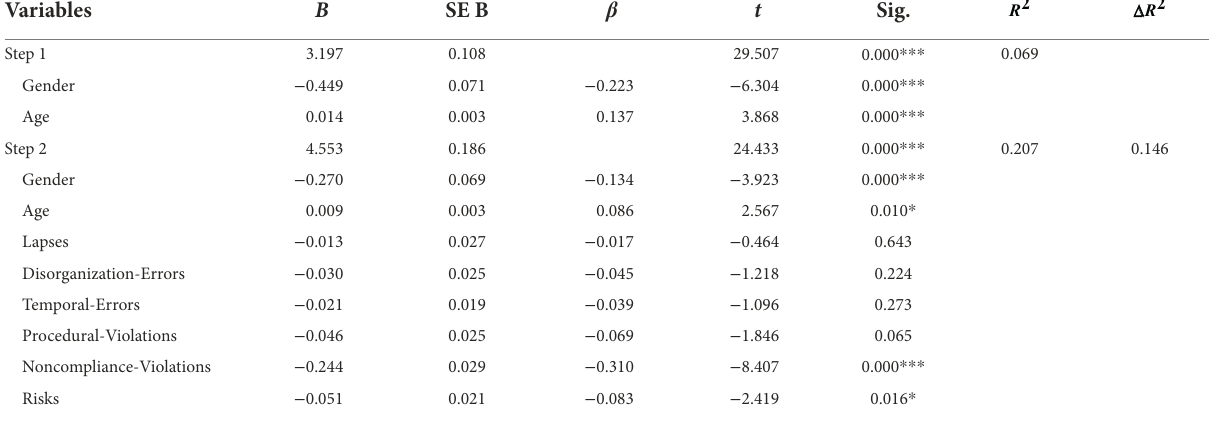
TABLE 2 Results of hierarchical multiple regressions for COVID-19 adherence behavior (Study 1).